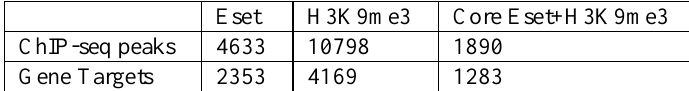
Table 2: Binding of Eset and histone methylation targets by ChIP-seq data.